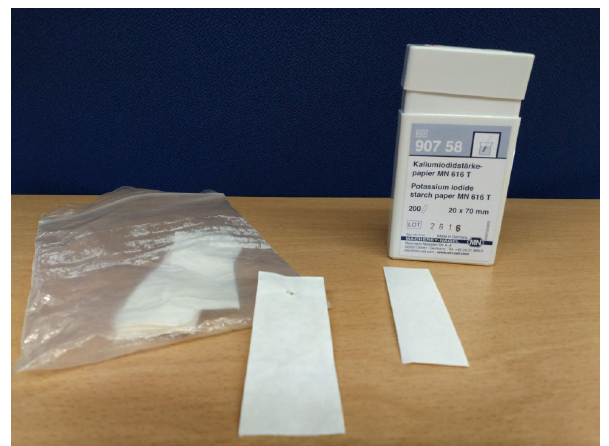
Figure 6. Example of strips (left: made by ourselves; right: com- mercial